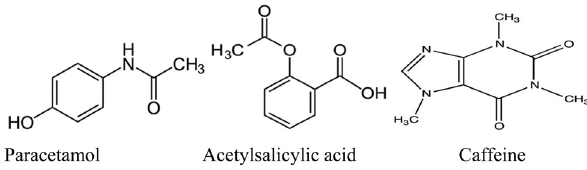
Figure 1: Chemical structures of the